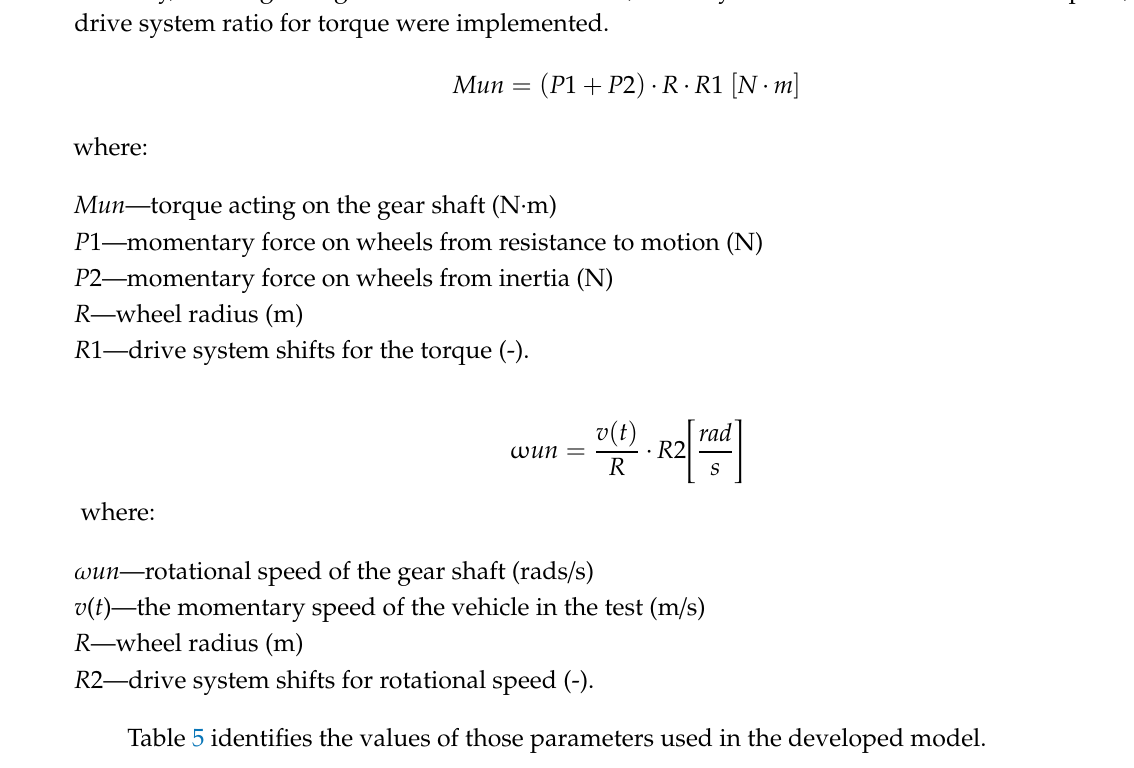
Table 5 identifies the values of those parameters used in the developed